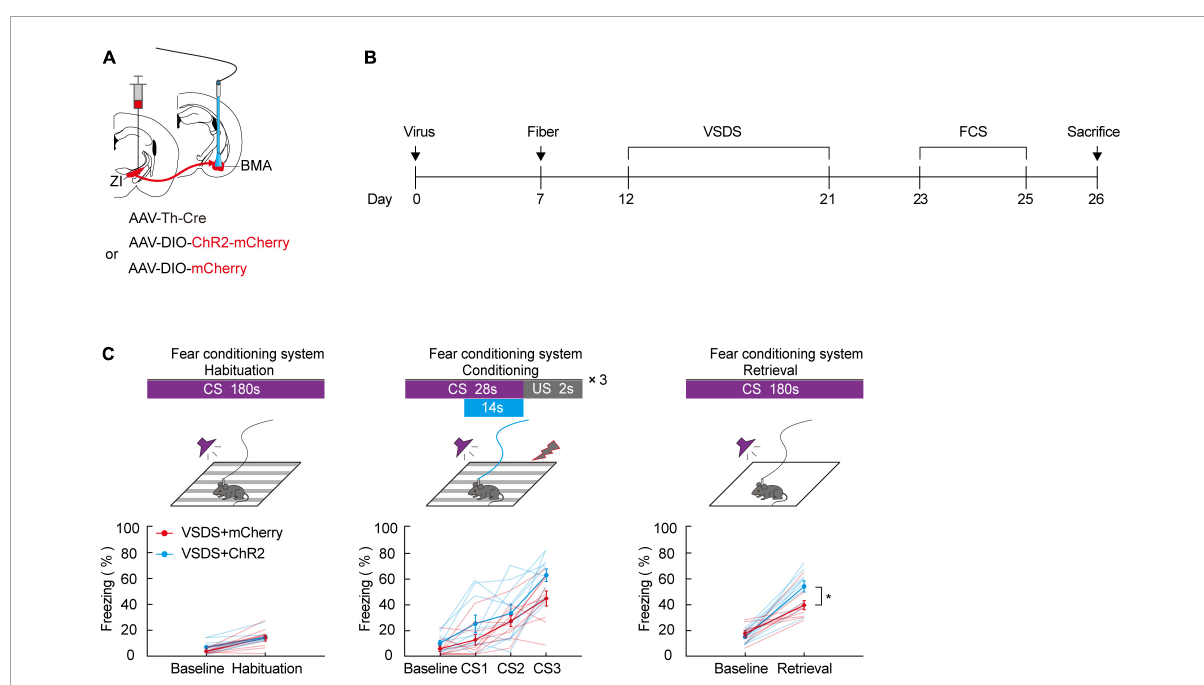
FIGURE5 Photogenetic activation of ZI-BMA TH + circuit remarkedly relieve 3C-VSDS-induced aversive associative learning disabilities. (A) Schematic representation of the virus injection and optic fiber implantation. (B) Experimental protocol timeline. (C) Behavioral paradigm of fear-conditioning system and its corresponding freezing behavior (habituation phase, two-way RM ANOVA, group: p = 0.3253, time: p < 0.0001, interaction: p = 0.3456; post hoc Sidak’s test, baseline: VSDS + mCherry vs. VSDS + ChR2: p = 0.3238; habituation: VSDS + mCherry vs. VSDS + ChR2: p = 0.9361. Conditioning phase, two-way RM ANOVA, group: p = 0.0572, time: p < 0.0001, interaction: p = 0.3033; post hoc Sidak’s test, baseline: VSDS + mCherry vs. VSDS + ChR2: p = 0.8166; CS1: VSDS + mCherry vs. VSDS + ChR2: p =